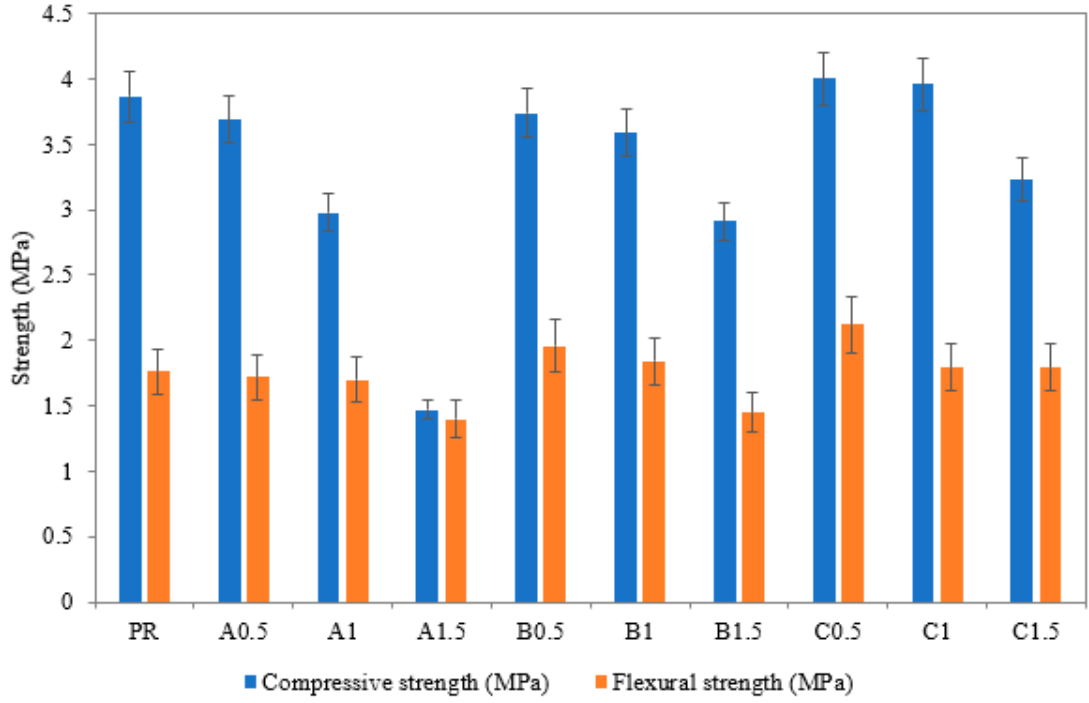
Figure 9. Compressive and flexural strengths of studied lime-based plasters.